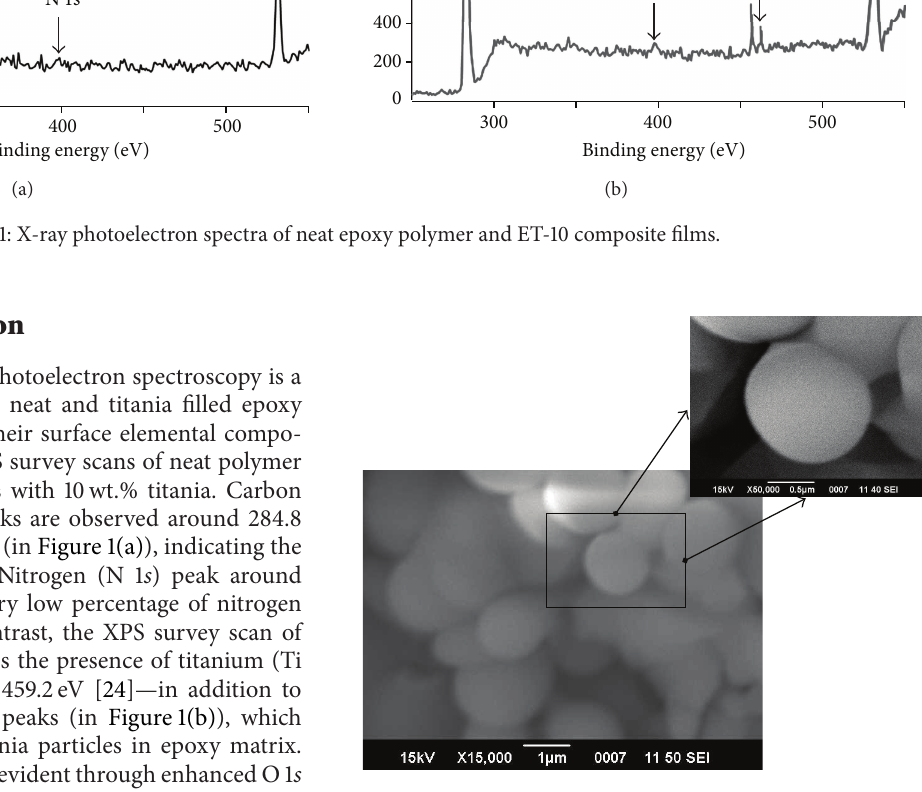
Figure 2: SEM images of submicron titania particles: the size of particles is in the range of 600–800